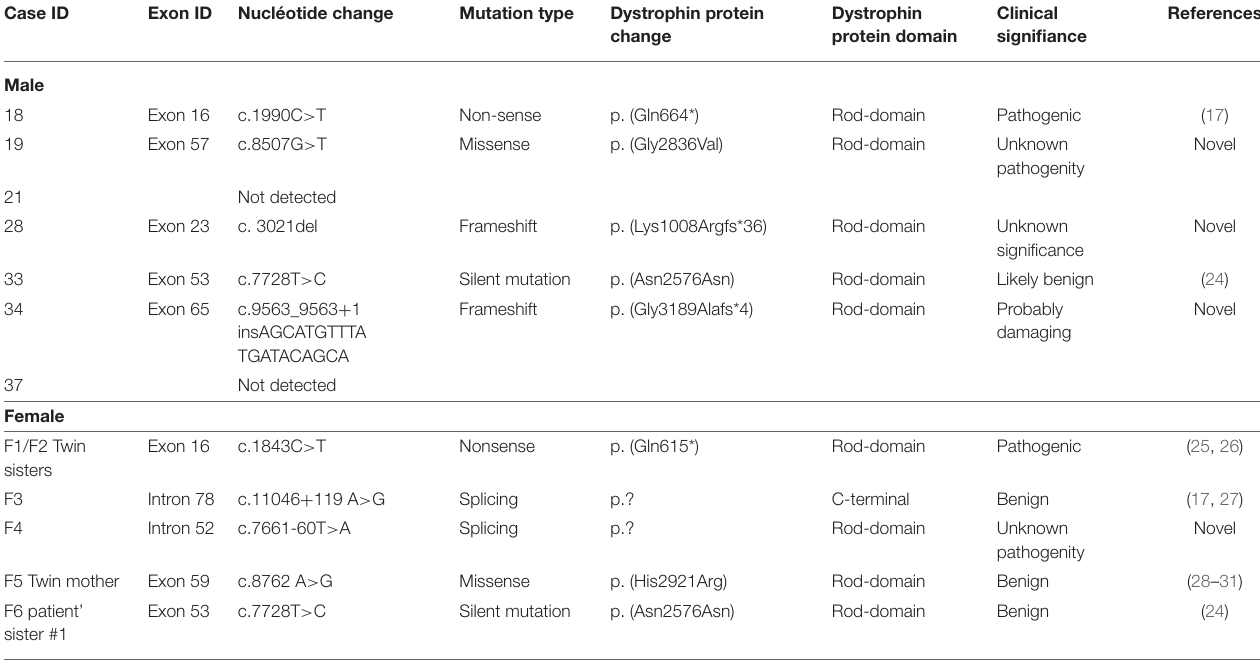
TABLE 2 | Variants detected by Sanger sequencing in analyzed